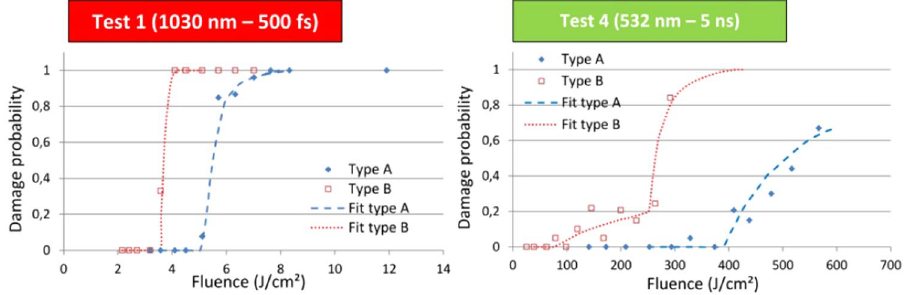
Figure 3. Density of defects. Damage probability curves and corresponding fits for tests 1 and 4 (as an illustration). The damage probability curves are fitted following a laser-induced damage model based on a two- parameter distributed defect ensemble. The values of defect densities retrieved for each test are summarized in Table 1.